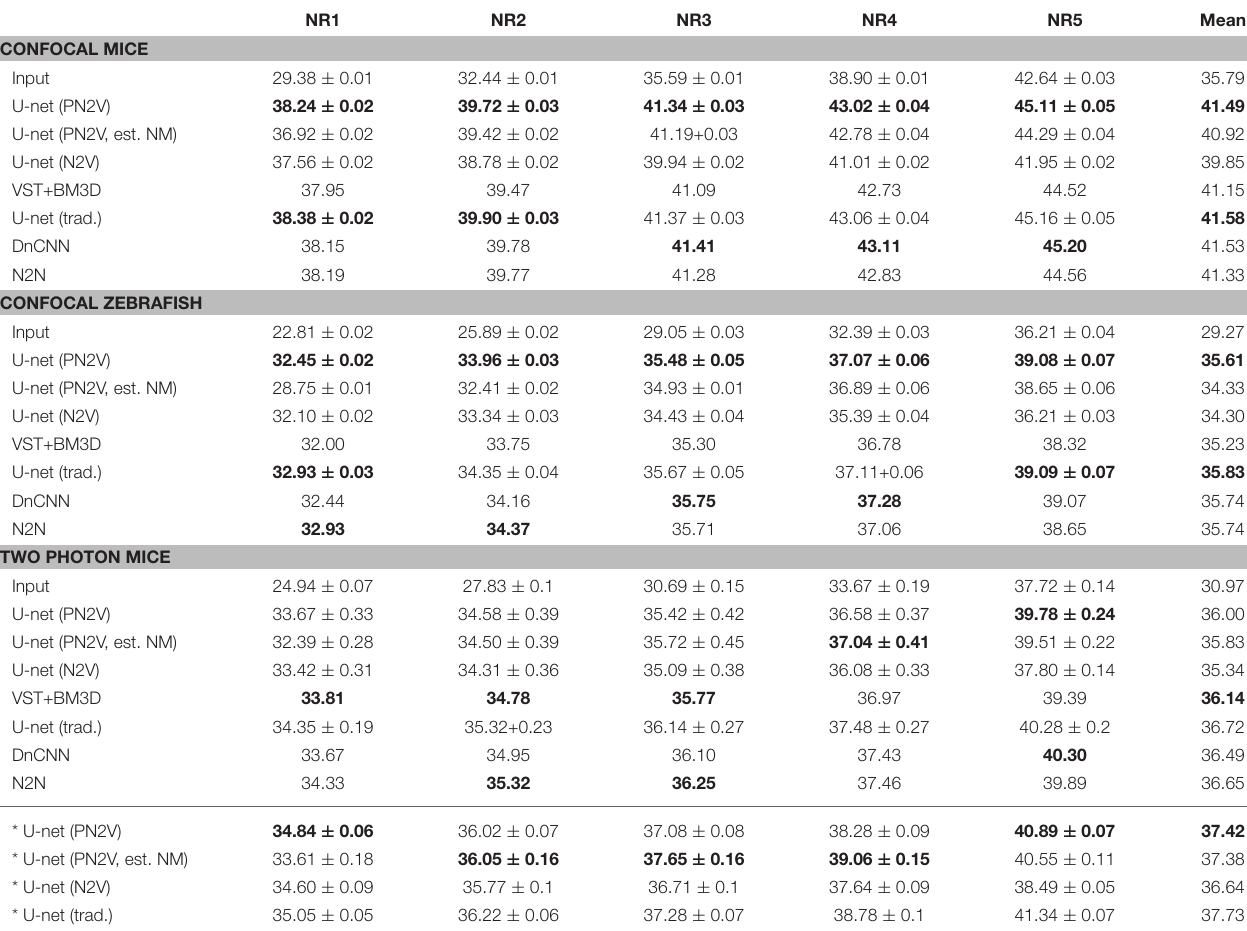
TABLE 1 | Results of PN2V and baseline methods on three datasets from Zhang et al.